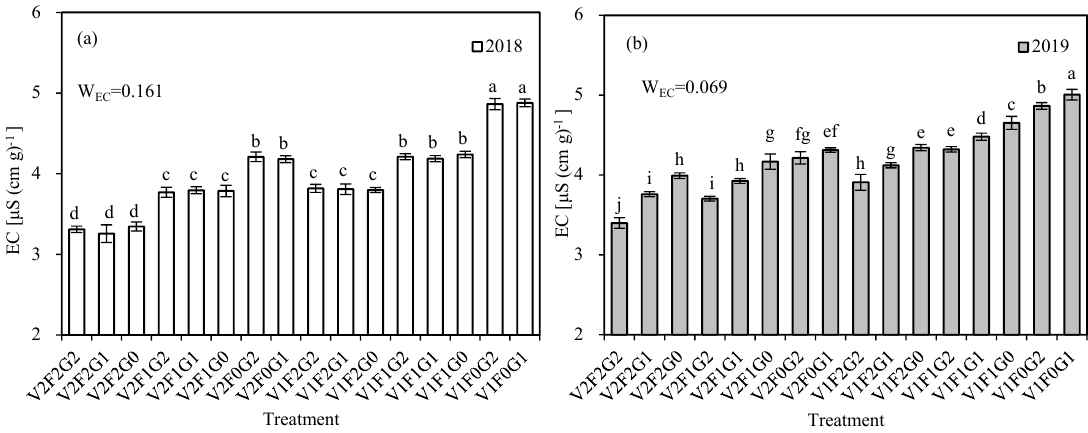
Figure 2. Leachate electrical conductivity (EC) and weight of EC determined using the entropy method (W EC ) in 2018 ( a ) and 2019 ( b ). V, vegetative; F, flowering; G, grain-filling; 2, sufficient irrigation; 1, 50% sufficient irrigation; 0, no irrigation. Inserted error bars denote standard error of the mean. Different letters above error bars indicate significant differences among treatments within a year at a 5% probability level using Duncan multiple range test.